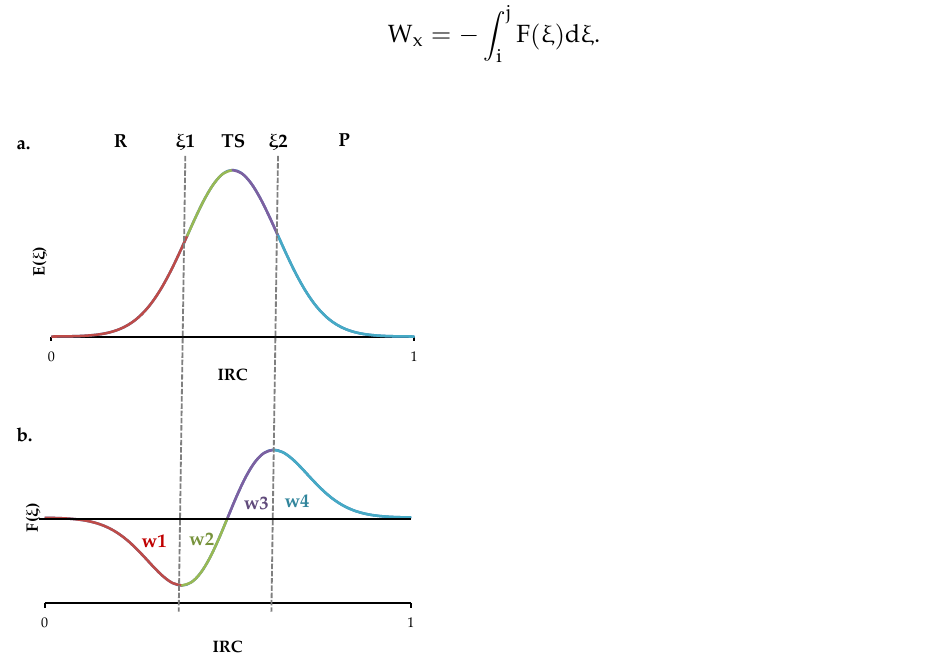
Figure 9. Potential energy profile ( a ) and reaction force profile ( b ) for a single step reaction along the IRC.